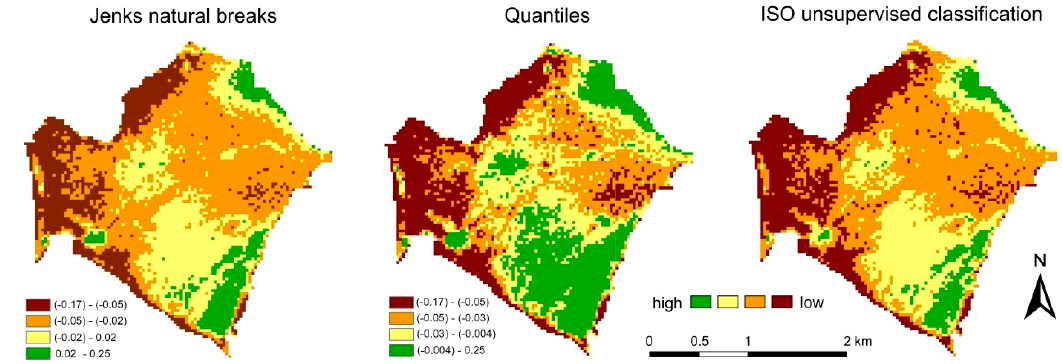
Figure 5. Normalized Di ff erence Vegetation Index (NVDI) analysis of the Elveflya outwash fan.